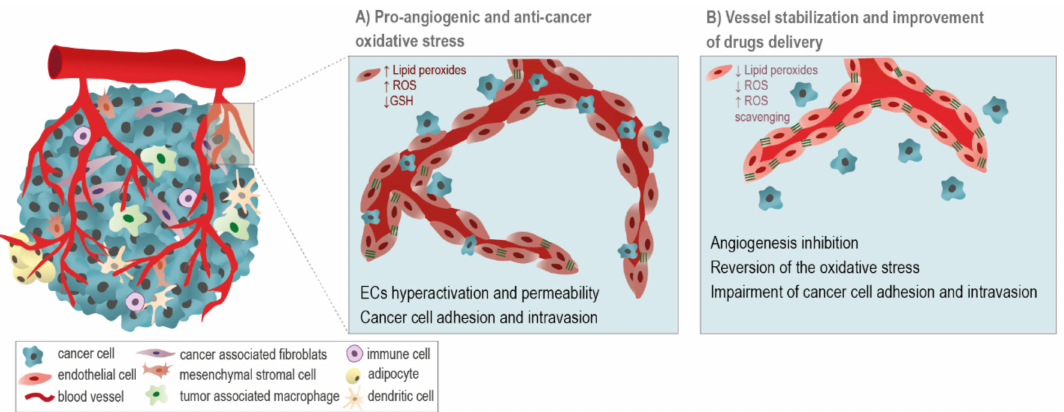
Figure 3. Increased oxidative stress activates endothelial cells (ECs) and kills cancer cells, and antioxidant mechanisms can stabilize vessels and improve anti-cancer chemotherapy. ( A ) A pro-angiogenic oxidative microenvironment, through the increased generation of ROS, the accumulation of lipid peroxides and glutathione (GSH) depletion is implicated in the promotion of ECs hyperactivation, vessels leakiness, and cancer cells migration and intravasation. ( B ) ROS scavenging activity is anti-angiogenic, since on one hand, it impairs the ECs activation, and on other hand, it promotes vessels normalization, pivotal to impair metastasis and improve the delivery of chemotherapeutic